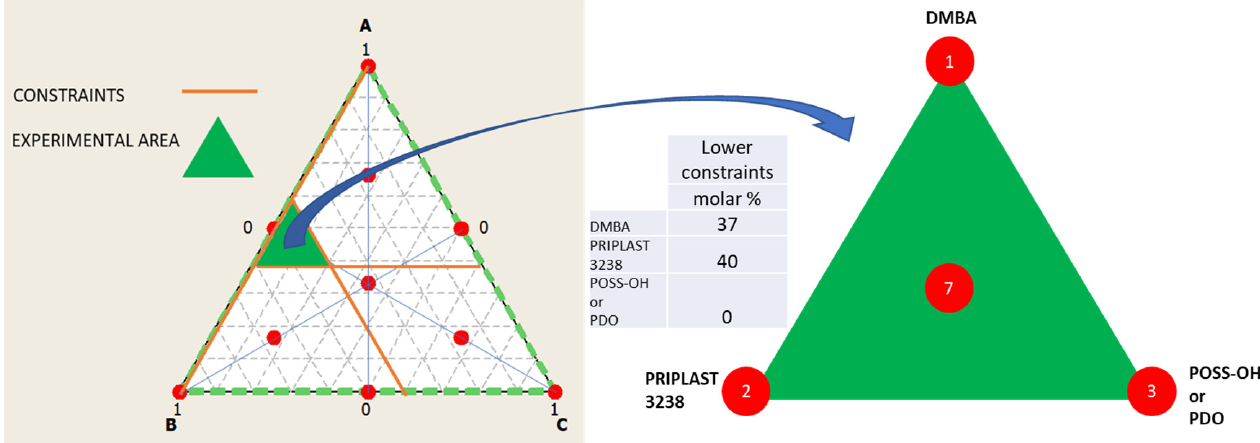
Figure 3. Ternary mixture design of experiments employed to study the proportion between the tree diols that form part of the polymer. Left : full design surface area in white with all the theoretical experimental points marked in red and studied area in green, which is delimited by the lower constraints stablished for component A (DMBA) and B (Priplast 3238). Middle: table summarizing the lower constraints stablished for the diols. Right : area studied and experimental points of the simplex design plot (1, 2, 3, 7).